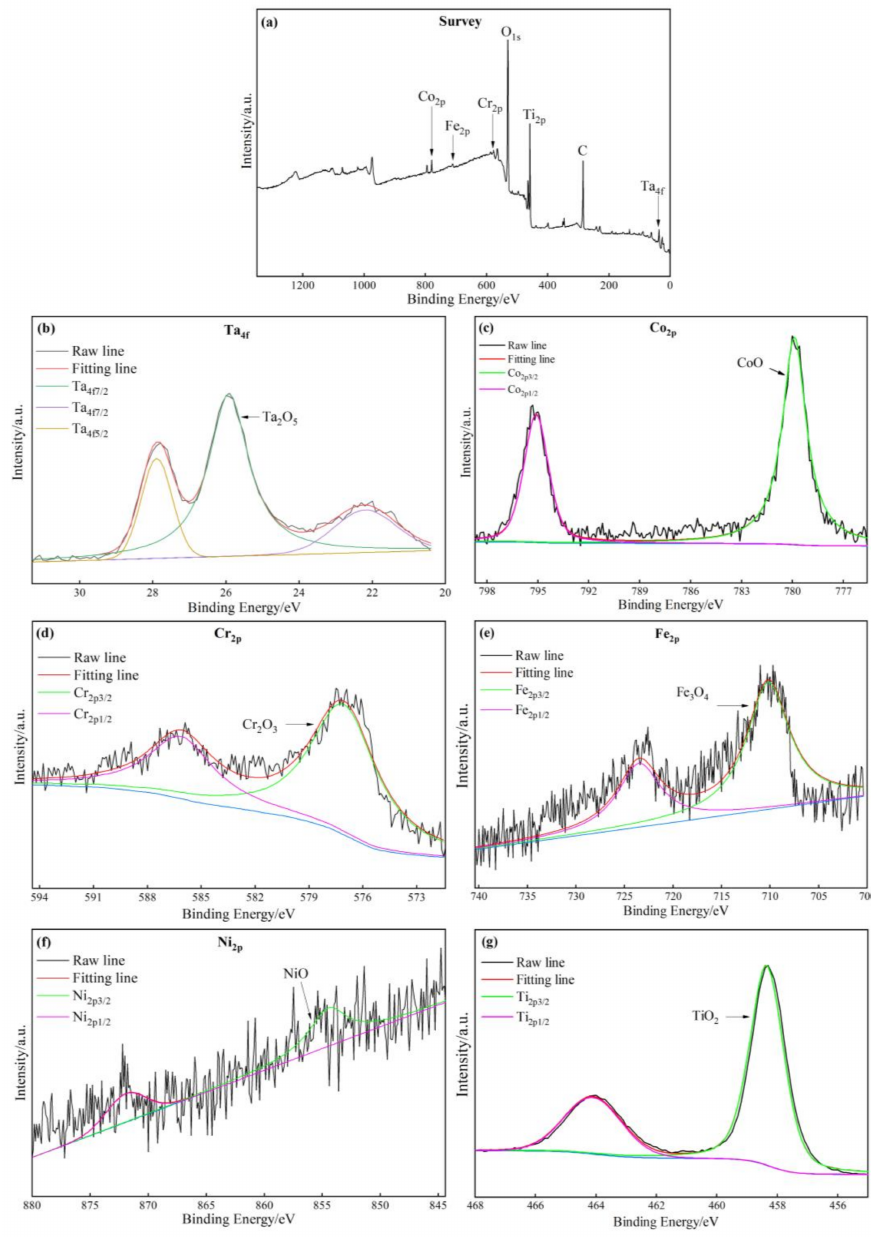
Figure 5. XPS spectra of the oxide film formed on the surface of coating with Ta in 3.5 wt.% NaCl solution: ( a ) survey; ( b ) Ti 2p ; ( c ) Co 2p ; ( d ) Cr 2p ; ( e ) Fe 2p ; ( f ) Ni 2p ; and ( g ) Ta 4f